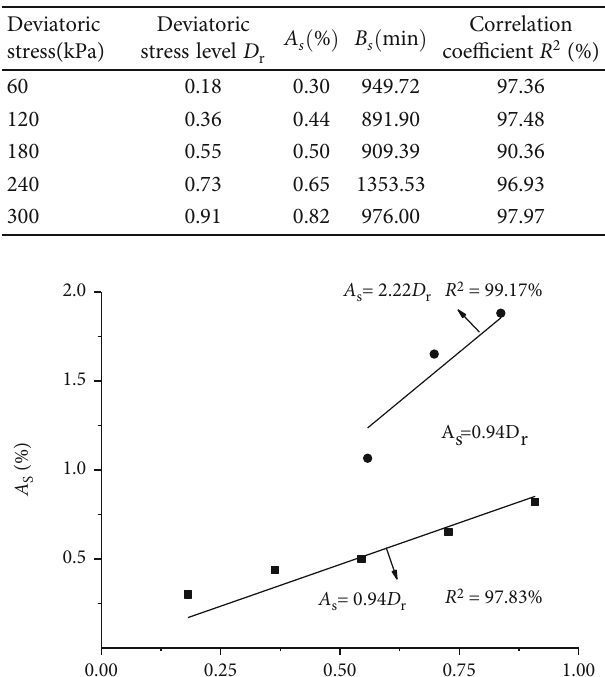
Figure 18: Model parameter A